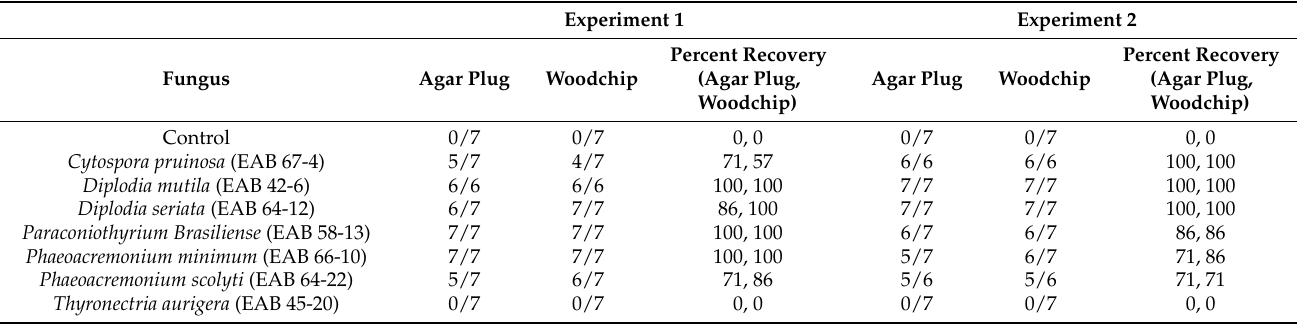
Table 3. Recovery of fungi re-isolated for both treatments agar plug and woodchip from inoculated F. americana trees.